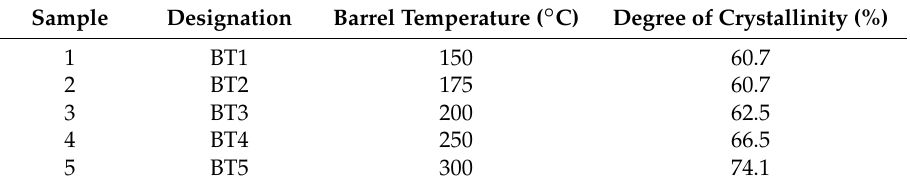
Table 5. Differential scanning calorimetry (DSC) results showing the influence of barrel temperature.